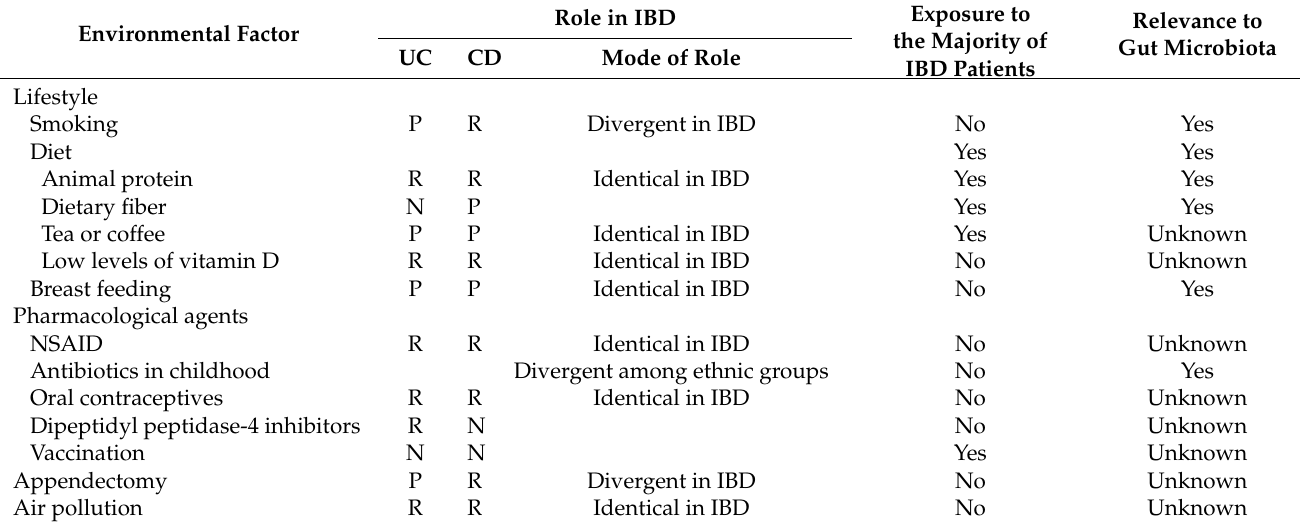
Table 2. Environmental factors in inflammatory bowel